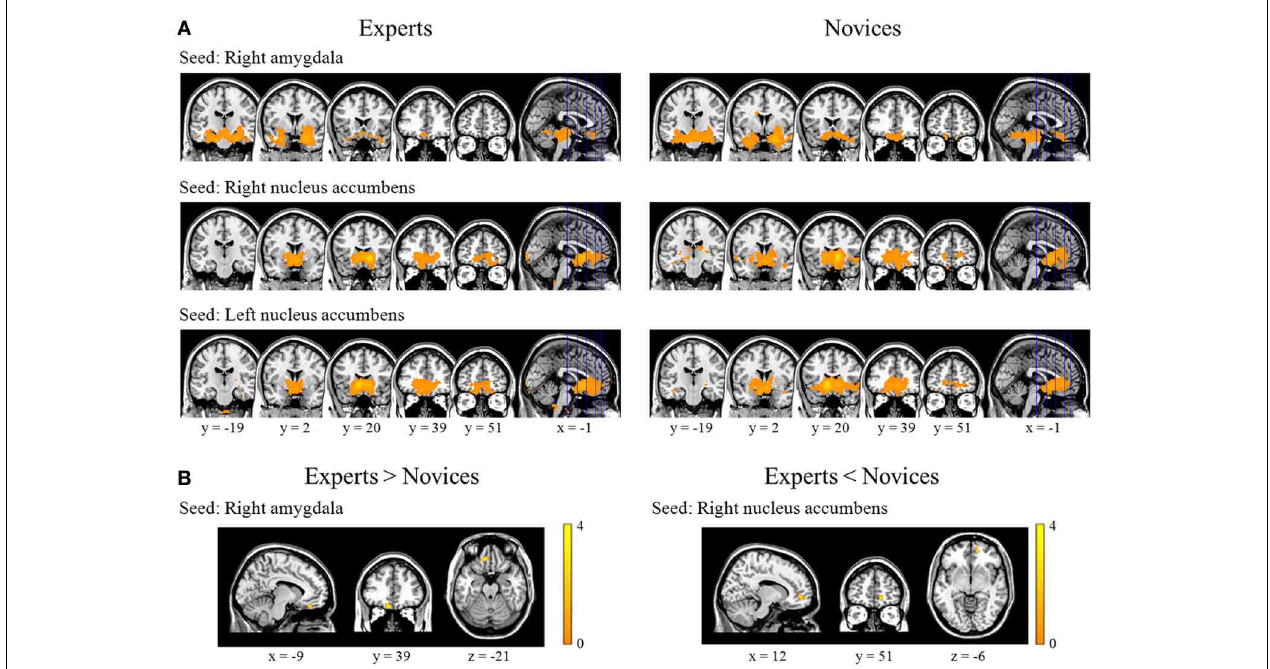
FIGURE 2 | Results from within- and between-group analyses of resting-state functional connectivity. These figures provide significantly positive correlation maps for the right amygdala, right nucleus accumbens, and left nucleus accumbens as seed regions in experts (the left column) and